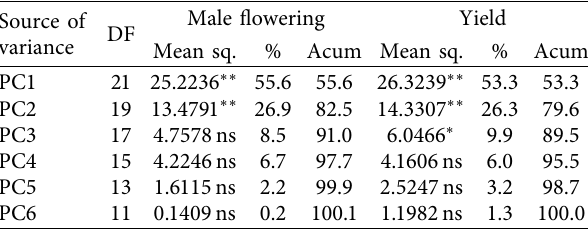
∗∗ , ∗ and ns: significant at the 0.01 and 0.05 probability levels, respectively, and